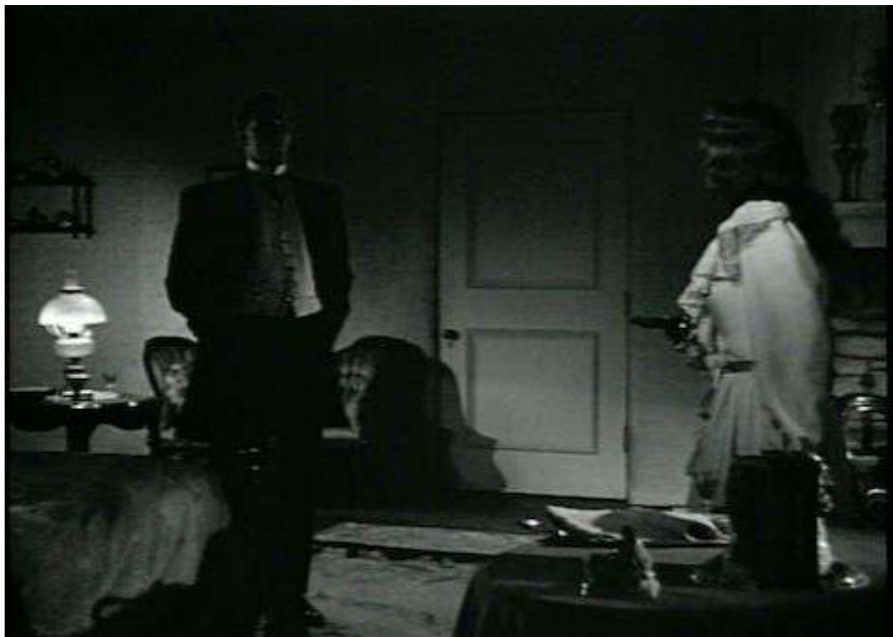
Figure 6: The bride with a gun in Pursued